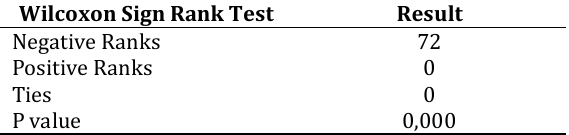
Table 2. The results of the effect of foot massage on decreasing the peripheral neuropathy diabetic complaints of the patients with